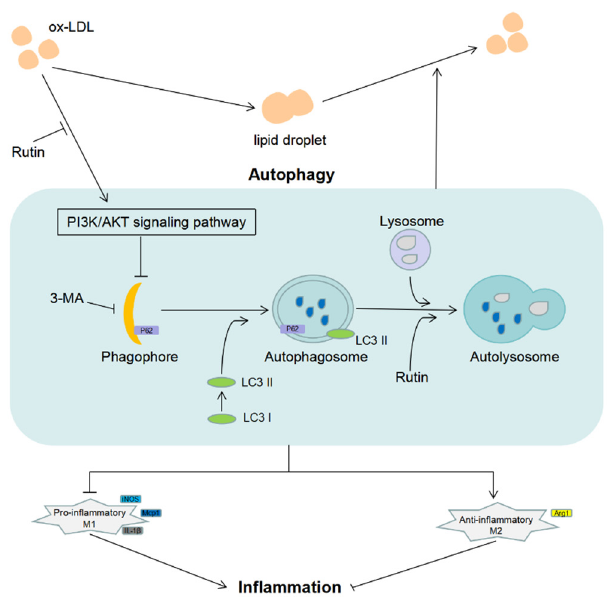
Figure 6. Schematic diagram of the anti-atherosclerosis effect of rutin.